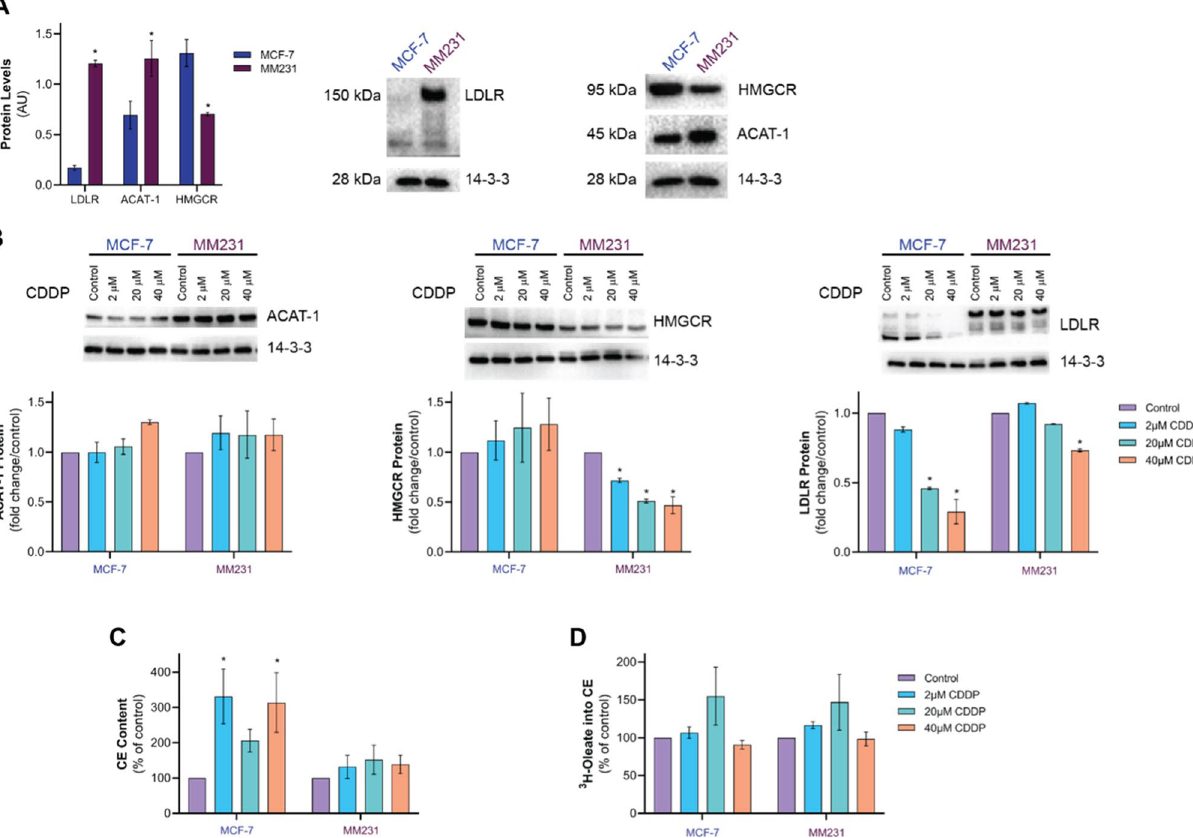
Fig. 5 Effect of CDDP on CE metabolism in MCF-7 and MDA-MB-231 cells. A Representative immunoblots and densitometric quantitation of LDLR, ACAT-1, and HMGCR protein levels in MCF-7 and MDA-MB-231 (MM231) cells. B Representative immunoblots and densitometric quantitation of ACAT-1, HMGCR and LDLR protein levels in MCF-7 and MDA-MB-231 cells treated with the solvent vehicle (Control) or CDDP for 48 h. MCF-7 and MDA-MB-231 cell ( C ) CE content and ( D ) cholesterol esterification following culturing in solvent vehicle (Control) or CDDP for 24 h. Data are mean ± SEM of at least three independent experiments performed in triplicate. *p < 0.05 vs. MCF-7 cells by unpaired Student’s t-test (A). *p < 0.05 vs. Control (vehicle-treated cells) within each experiment by one-way ANOVA followed by Dunnett’s post hoc test ( B – D